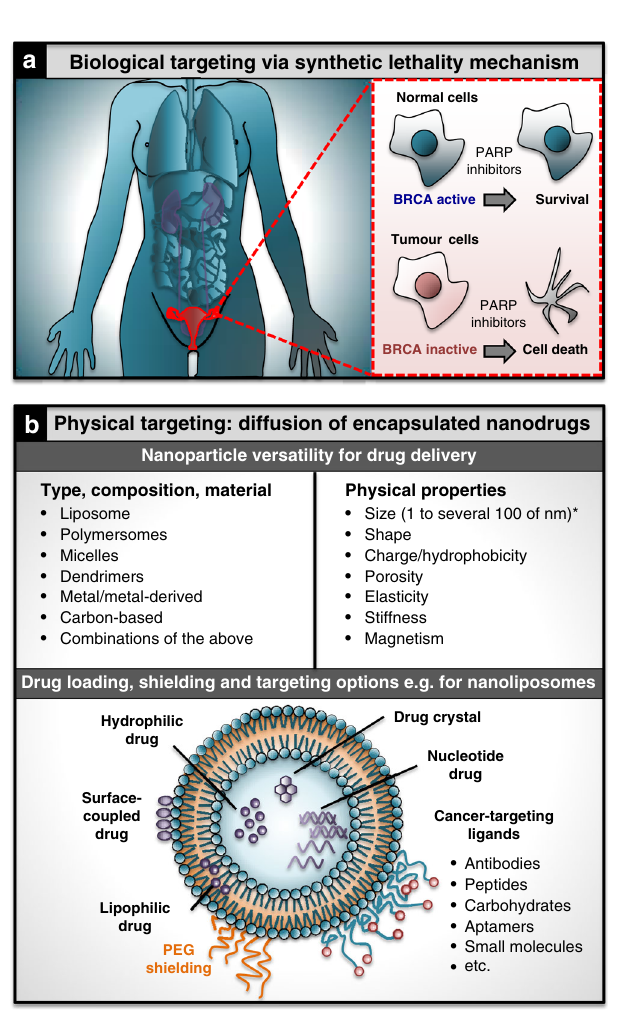
Fig. 1 Different approaches towards targeting of cancer over normal cells. a Biological targeting: example of targeted killing of cancer cells through synthetic lethality by exploiting genetic differences in the BRCA genes between normal and cancer cells using conventional small-molecule drugs (PARP inhibitors). b Physical targeting: engineering drug-delivery systems that can reach and deliver cargo to cancer over normal cells, based on passive/targeted diffusion of nanoparticles that can vary in their make- up (organic and inorganic materials), and display a wide range of physical properties (top). Drug loading, targeting and shielding of nanoparticles can be achieved in distinct ways, as illustrated for nanoliposomes as a key example (bottom). Analogous options exist for other nanoparticle types but require different engineering methods depending on the underlying material, e.g., to allow for surface functionalisation with targeting ligands 2 . PEG polyethylene glycol. *Strictly speaking nanoparticles are de fi ned by the International Union of Pure and Applied Chemistry (IUPAC) as particles of any shape ranging in dimension from 1 to 100 nm, but structures up to several 100 nm in size are commonly